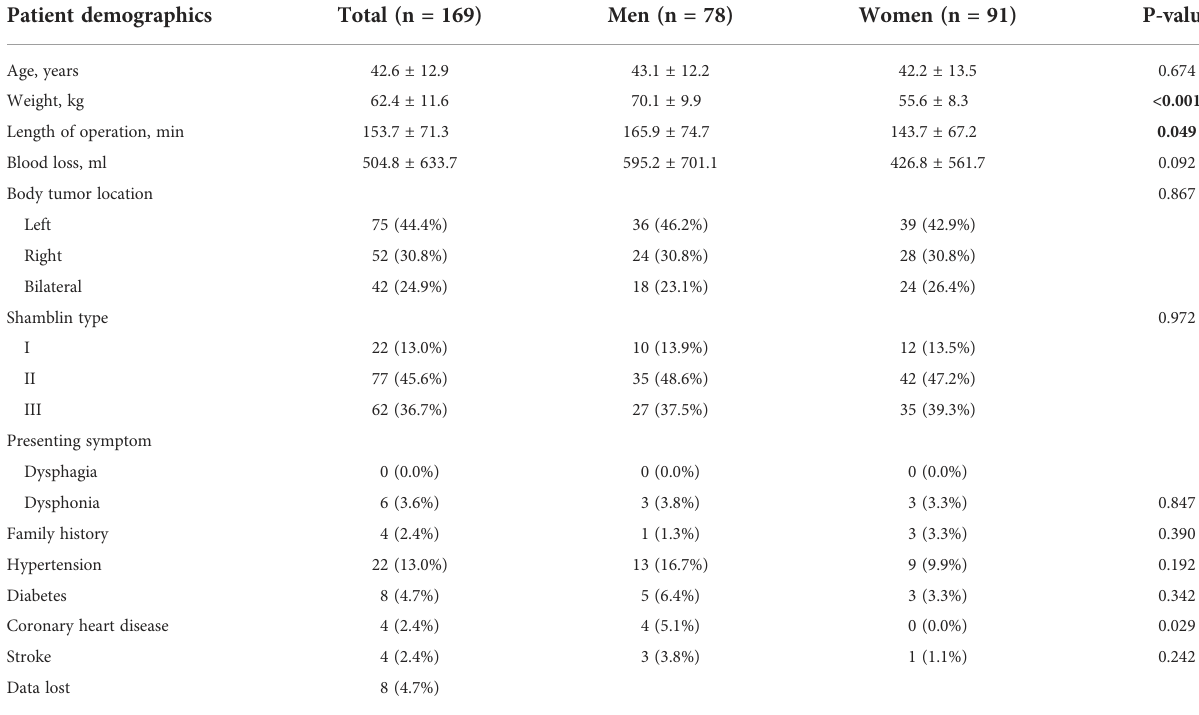
TABLE 1 Demographic and clinical characteristics of study population.